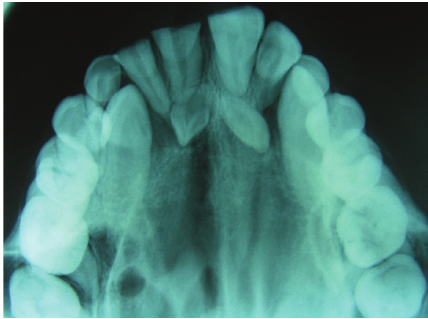
Figure 6: A well-developed mesiodens with talon cusp: a typical superimposed inverted V-shaped radiopaque structure.